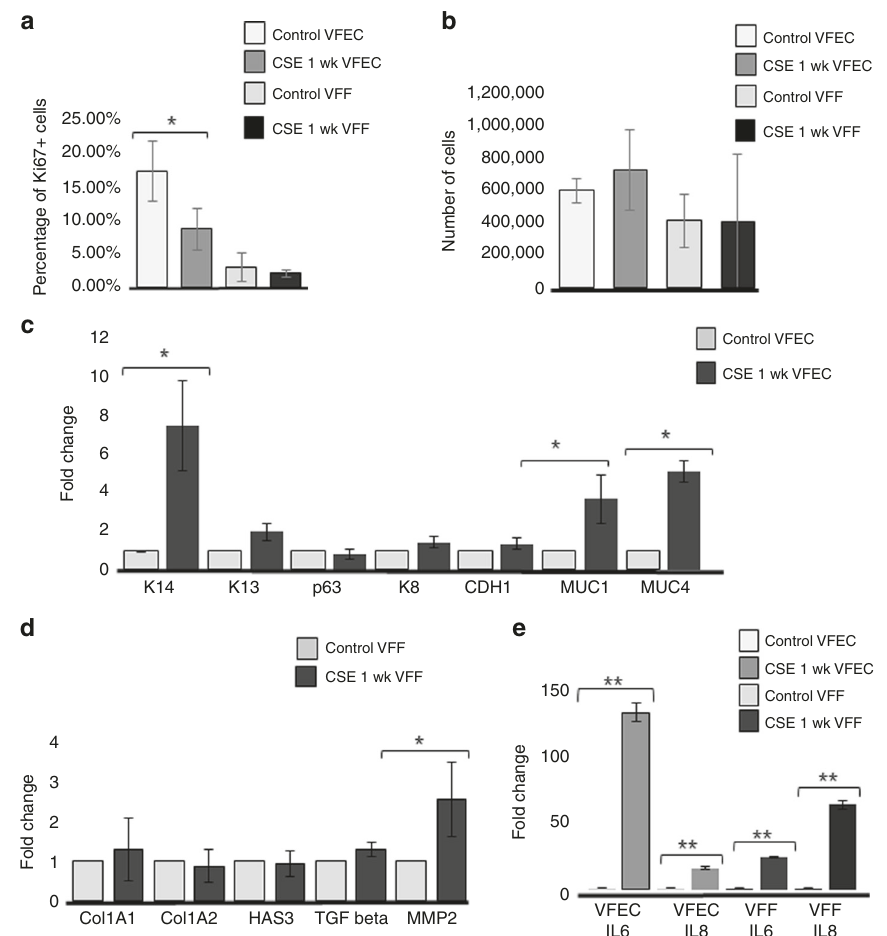
Fig. 10 Transcript levels of characteristic strati fi ed and epithelial markers after 5% CSE exposure for 1 week. a Quantitative assessment of cell proliferation in control VFEC and VFF vs VFEC and VFF exposed to the CSE. Error bars represent ± standard error of the mean, n = 3.Two-sample t tests con fi rmed statistical signi fi cant decreases in cell proliferation in CSE exposed VFEC only ( p < 0.05, expressed as *). b Quantitative assessment of the cell number sorted by fl ow cytometry. Error bars represent ± standard error of the mean, n = 3. Two-sample t tests showed that there was no signi fi cant difference in cell numbers between control and CSE exposed VFEC and VFF ( p- values were above the threshold, p > 0.05), indicating that CSE does not affect the viability. c Changes in the expression levels of selected epithelial genes: Cytokeratin 14, 13, 8, p63 gene, CDH1 (E-Cadherin), MUC1, MUC4 in control VFEC, and 5% CSE exposed VFEC. Cells were isolated from entire constructs in control and 5% CSE exposed experimental groups. We used two-sample t tests to assess statistical signi fi cance in tested genes. Increased expression levels of Cytokeratin 14, MUC1, and MUC4 in 5% CSE treated group were statistically signi fi cant ( p < 0.05, expressed as *). Error bars represent ± standard error of the mean, n = 3. d Changes in expression levels in structural (Col1A1; Col1A2; HAS3) and functional (TGF beta and MMP-2) genes in VFF. Cells were isolated from entire constructs in control and 5% CSE exposed experimental groups. Two-sample t tests con fi rmed statistical signi fi cance in MMP-2 expression only ( p < 0.05, expressed as *). P- values of other genes were above p > 0.05, suggesting the 5% CSE did not signi fi cantly change the morphology or function of VFF. Error bars represent ± standard error of the mean, n = 3. e Activation of pro-in fl ammatory genes, Il6 and Il8, in control and CSE exposed VFEC and VFF. VFEC and VFF were analyzed and evaluated independently, as they were sorted by the fl ow cytometry prior to RNA isolation. Two-sample t tests con fi rmed statistical signi fi cance in expression in pro-in fl ammatory genes in cigarette smoke extract exposed VFEC and VFF ( p < 0.01, expressed as **). CSE cigarette smoke extract, VFEC vocal fold epithelial cells, VFF vocal fold fi broblasts, wk. week. Source data provided as a Source Data fi hiPSC-derived VBP into functional VFEC was performed by replating VBP on top of collagen constructs seeded with primary VFF and their cultivation at an A/LI. The primary VFF cell line was developed from normal vocal folds obtained from a 21-year- old male donor 46 . This cell line has been shown to support proper differentiation of keratinocyte-like cells and their strati fi cation at an A/LI 14,42 . Use of conditional FAD medium along with co-